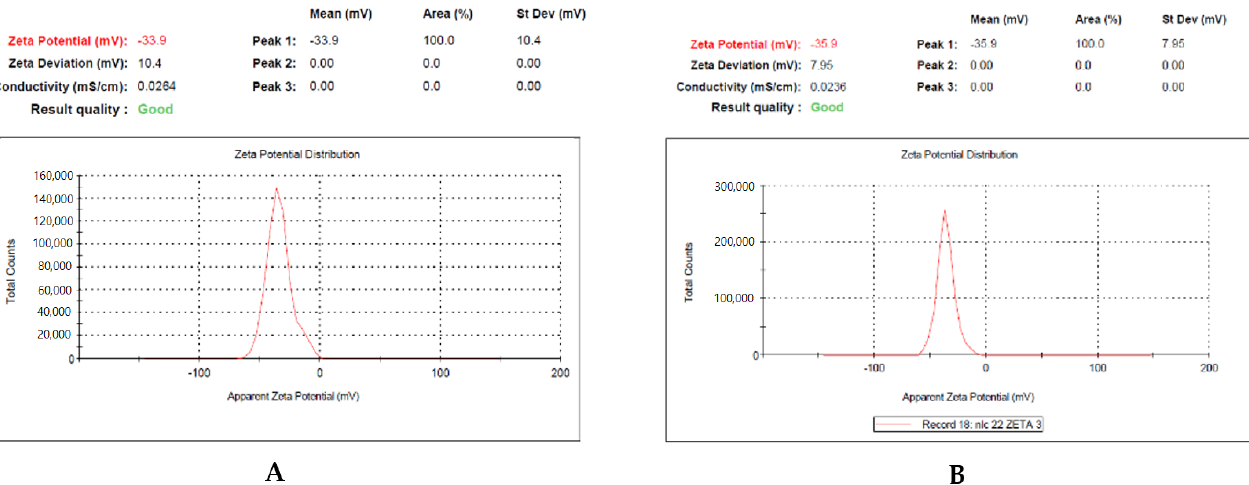
Figure 3. Data of zeta potential. ( A ): Nanoemulsion without drug; ( B ): Methotrexate-loaded nanoemulsion.